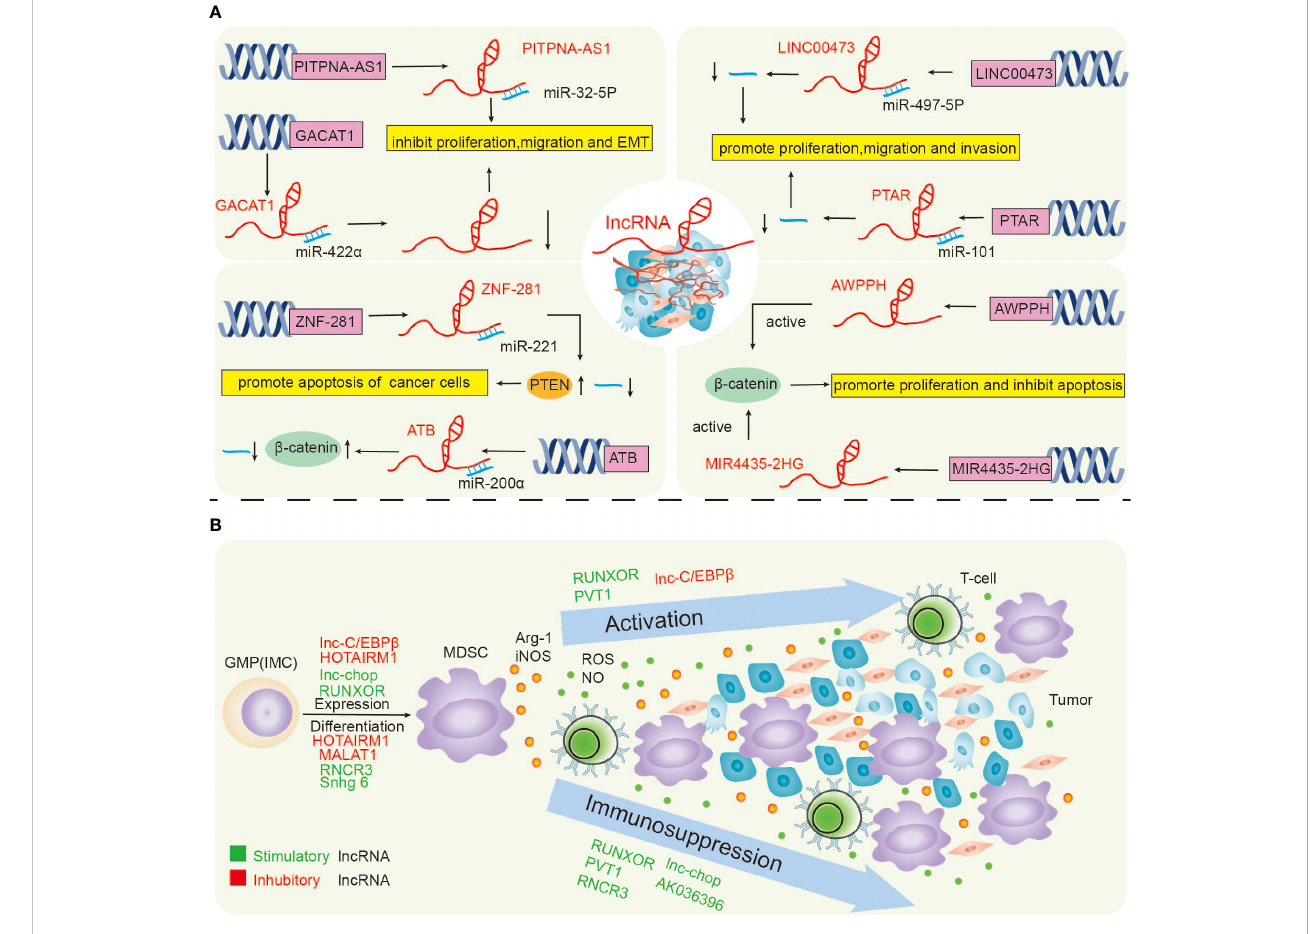
FIGURE 2 LncRNAs directly regulate lung cancer (A) , and the lncRNAs regulate lung cancer by regulating MDSCs (B)